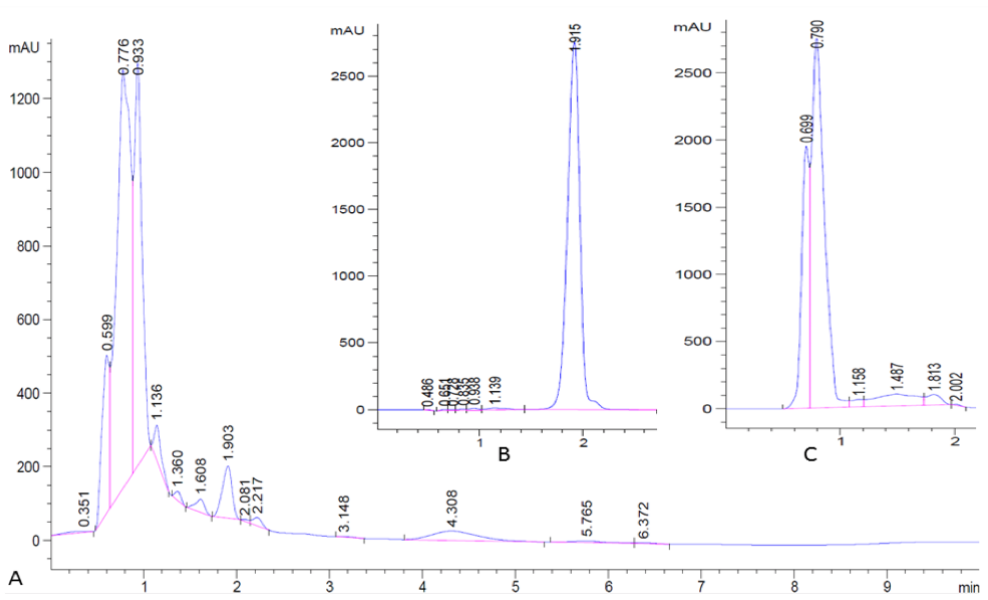
Figure 2. HPLC chromatogram. ( A ) Crude extract from Aspergillus terreus ; ( B ) pure lovastatin standard; ( C ) blank.